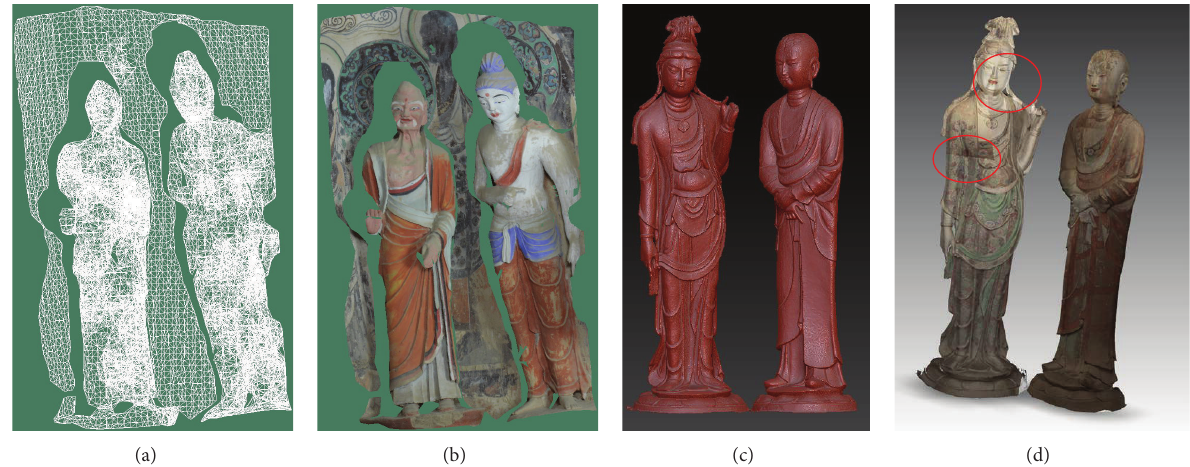
Figure 7: The 3D reconstruction results by our method and laser: (a) the triangular mesh by PFCPMS, (b) the 3D model reconstructed by PFCPMS, (c) the 3D model scanning by laser, and (d) the laser 3D model after texture registration.